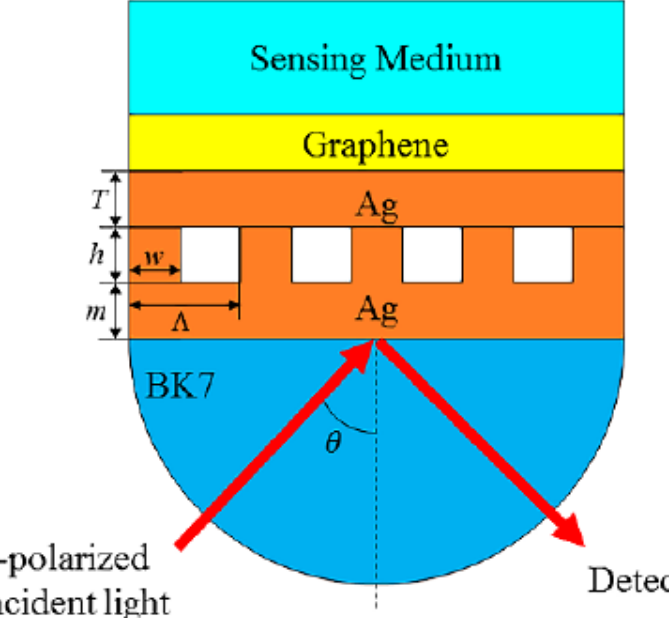
Figure 1. Schematic diagram of the proposed surface plasmon resonance (SPR) sensor with Ag gratings and graphene.